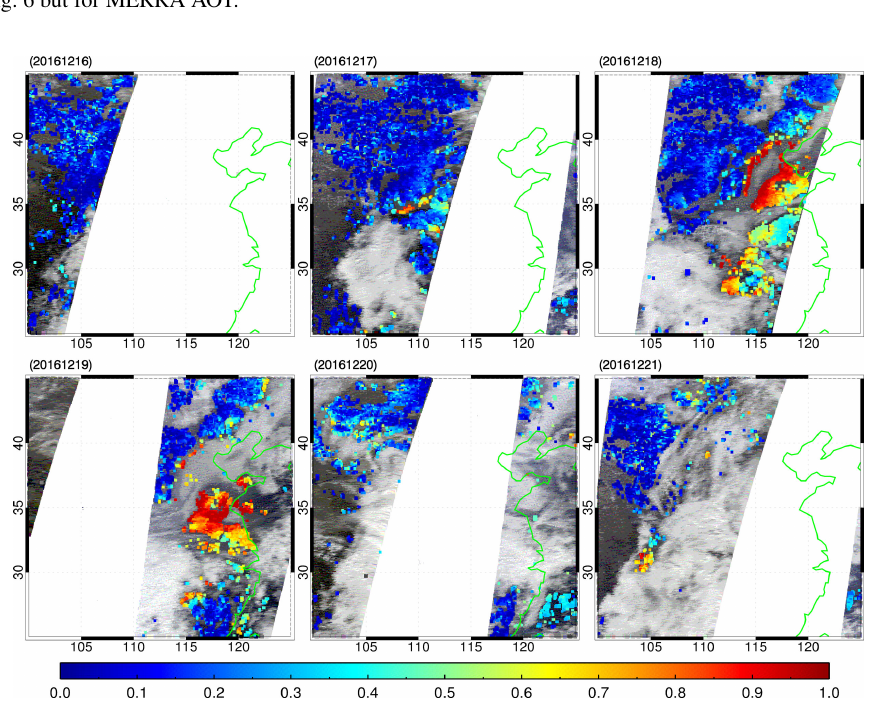
Figure 7. Same as Fig. 6 but for MERRA AOT.